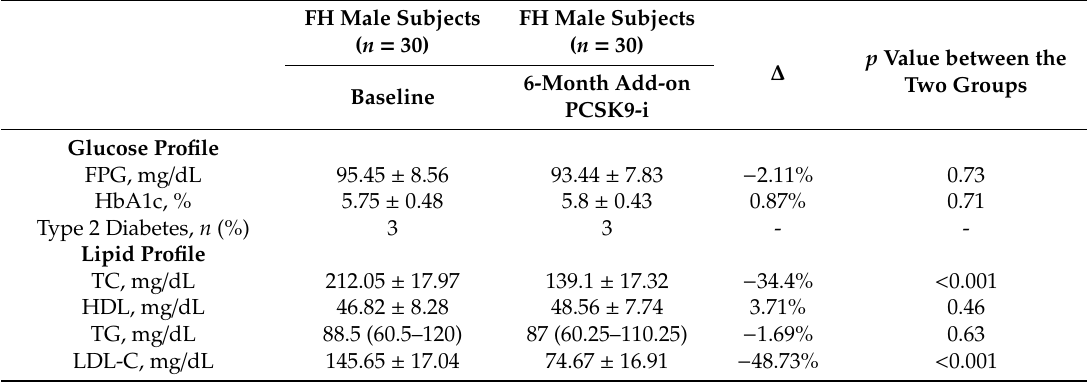
Table 2. Glucose, lipid, risk factor, and sexual function profiles of the study population at baseline and after six months of add-on